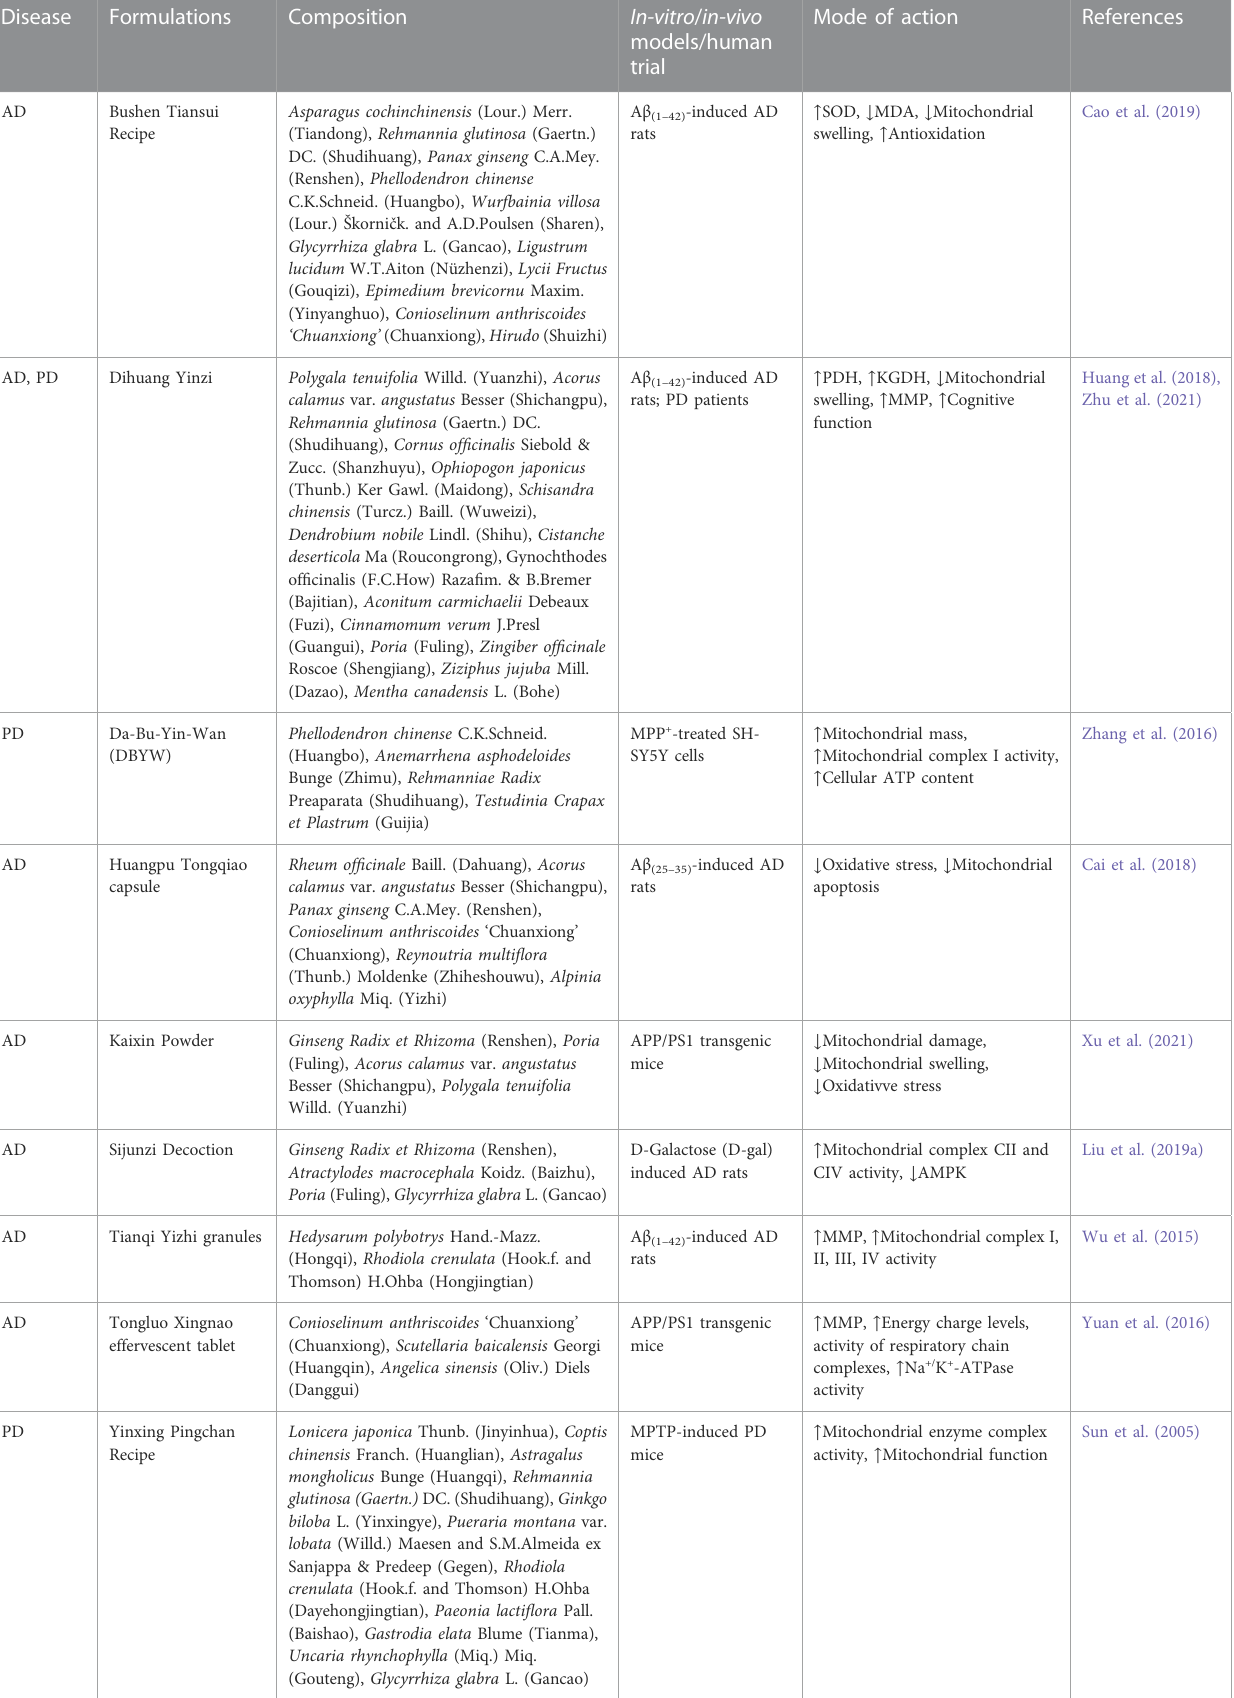
TABLE 1 List of traditional Chinese medicine (TCM) formulas treating neurodegenerative diseases (NDs) by alleviating mitochondrial dysfunction.